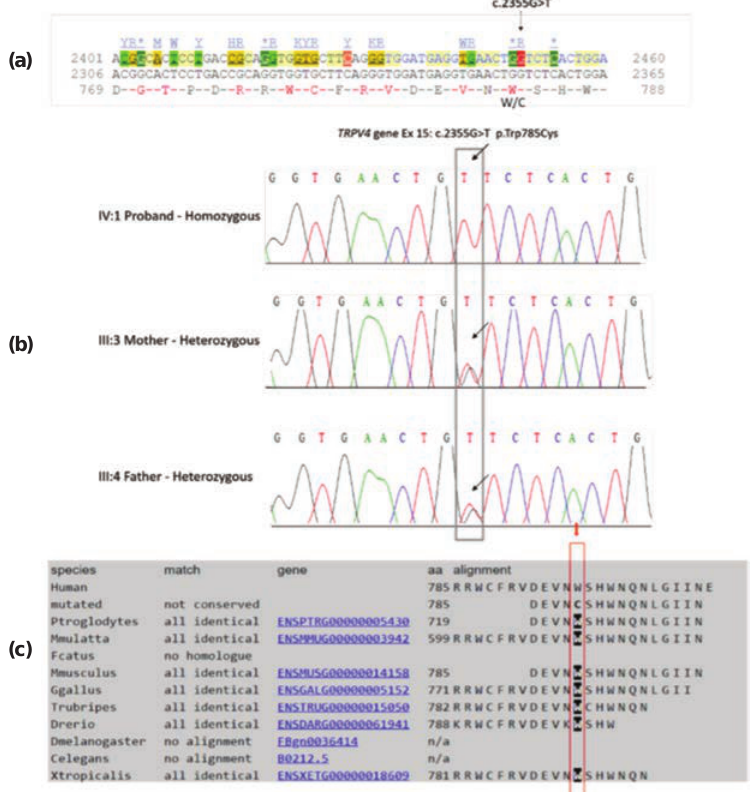
(a) The amino acid sequence of the TRPV4 gene and the position of the novel variant identified c.2355G > T p. (Trp785Cys) is Fig. 3: shown. (b) Electropherogram of the TRPV4 gene variant position: Proband showing homozygous c.2355G > T p. (Trp785Cys) missense variant at exon 15 of TRPV4 gene. Parents were heterozygous. (c) Tryptophan W at position 785 of TRPV4 gene is conserved in different